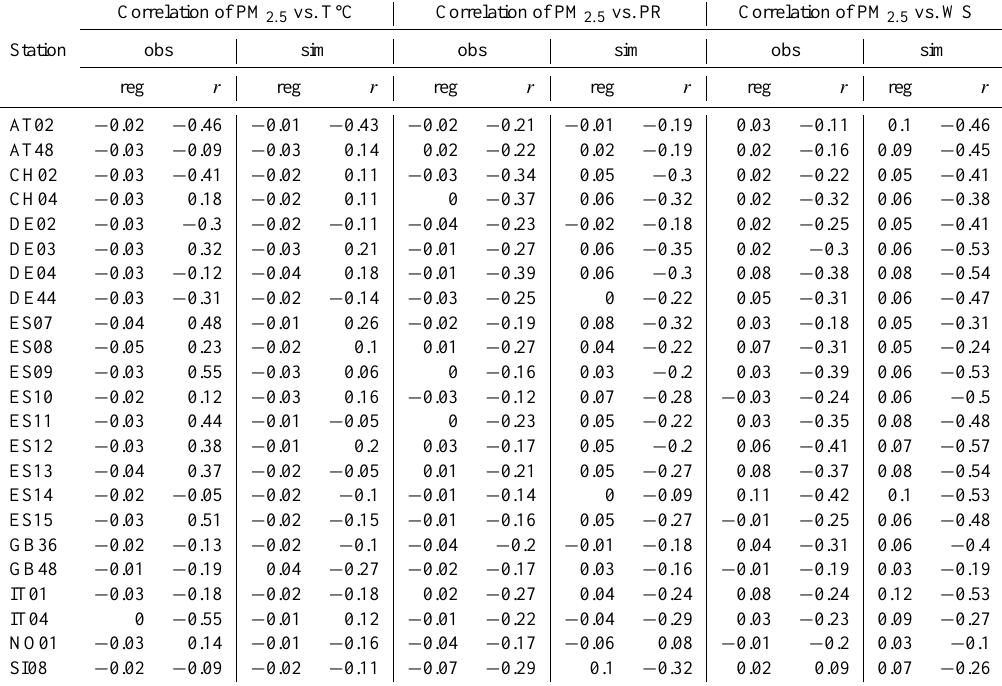
Table 3. Dynamic evaluation for PM 2 . 5 (without speciation): linear regression analysis of the correlation coefficients between the PM 2 . 5 and temperature (T°C), precipitation (PR), and wind speed (WS) as a function of the day lag (ranging from 0 to 2) for the observed (obs) and simulated (sim) concentrations. reg is the regression coefficient obtained from the regression analysis and r is the best correlation